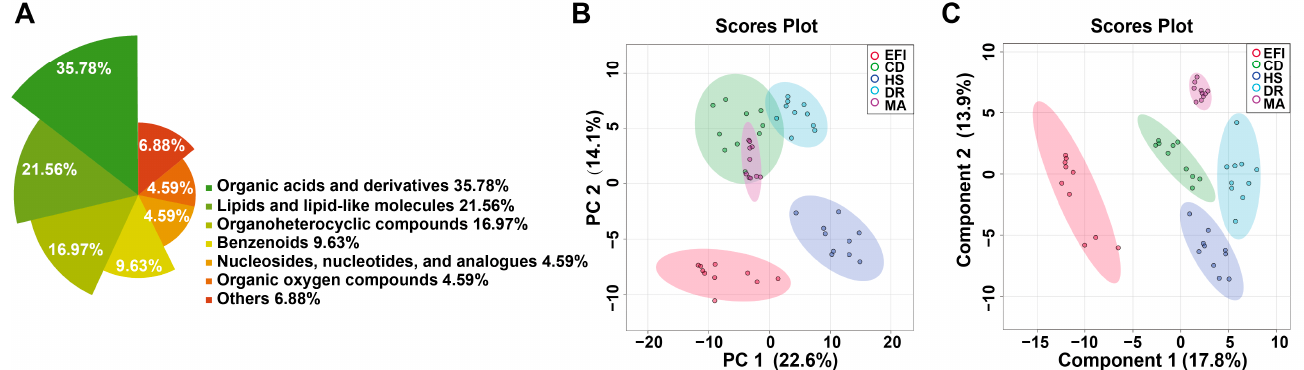
Figure 5. Overviews of metabolic profiles of brainstem tissue samples in the EFI and NDRDs mice. There were fifty mice in groups, n animal = 10, respectively. ( A ) Nightingale Rose Chart of metabolite classification. ( B ) PCA score plot. ( C ) PLS-DA score plot.